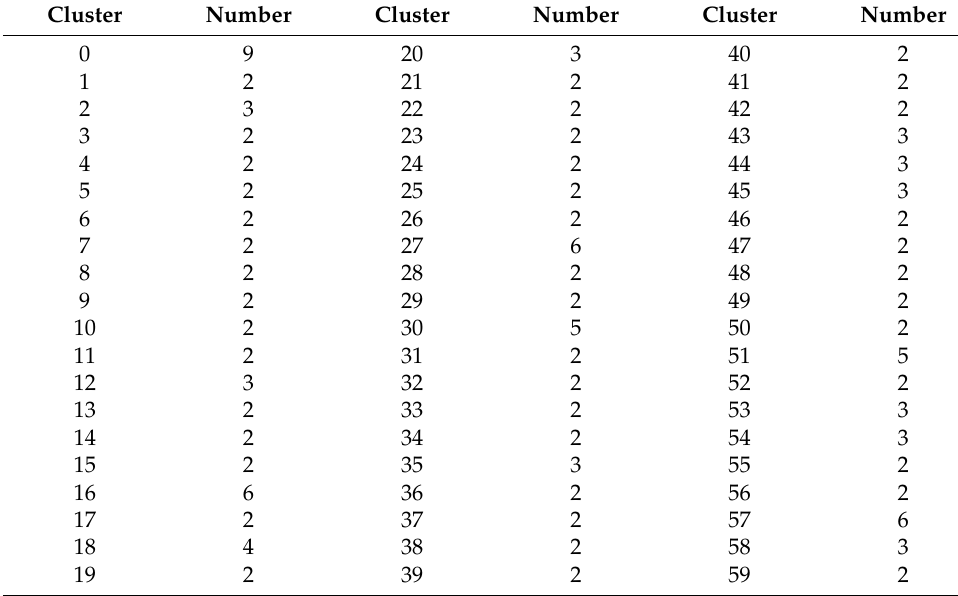
Table 1. Clusters and their respective sizes.